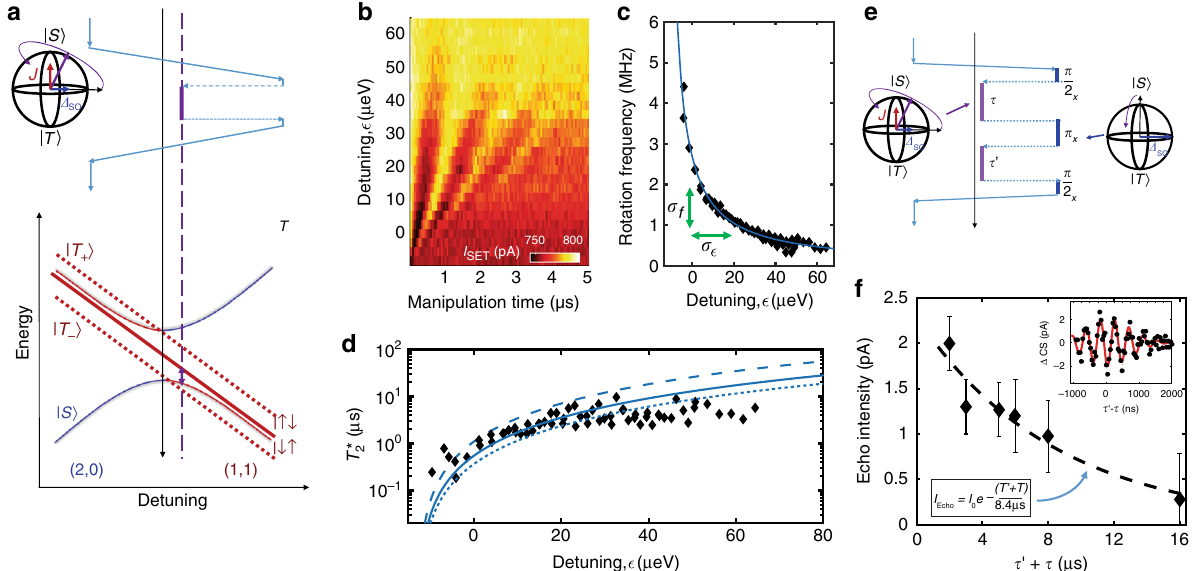
Fig. 4 Z- rotations and noise. a Energy Diagram and gate pulse schematic for controlling exchange rotations. We initialize the qubit into the S (2, 0) ground state and ramp adiabatically, such that it transfers to the ground in the (1, 1) charge sector. A fast pulse to and from a detuning, ϵ , where J is substantial drives coherent rotations around an axis depending on both J and Δ SO . Returning to the (2, 0) charge sector adiabatically projects the states onto the S (2, 0) and T 0 (1, 1) basis for measurement. b Measured charge sensor current as a function of the time spent rotating for various detuning points. Here, high current corresponds to a higher probability of measuring a singlet. c The extracted rotation frequency vs. detuning. The blue line is a fi t to the form ffiffiffiffiffiffiffiffiffiffiffiffiffiffiffiffiffiffiffiffiffiffiffi q as a function of detuning. We also plot the long integration time values from Fig. 3a. The blue lines are fi ts J ð ϵ Þ 2 þ Δ 2 , where J ( ϵ ) ∝ ϵ − 1 . d Extracted T ? 2 SO (cid:5) (cid:5) (cid:5) (cid:5) (cid:3) 1 , where the extracted charge noise, σ = 1 ffiffi (cid:4) d f μ eV (dotted). e Gate pulse schematic for a Hahn-echo p to the form T ? ϵ , is 1 (dashed), 2 (solid) and 3 2 πσ e d ϵ 2 sequence. We initialize the qubit into the S (2, 0) ground state and transfer the system to the (1, 1) charge sector with a rapid adiabatic pulse such that it remains in a singlet state. Combinations of Δ SO -rotations about the X -axis and J -rotations about a second axis provide access to entire Bloch sphere. This echo sequence counteracts low frequency noise, prolonging qubit coherence. f Hahn-echo amplitude as a function of total time, τ ′ + τ , exposed to charge = 8.4 μ s. (inset) noise at detuning ϵ . The error bars represent 95% con fi dence interval. A fi t to an exponential decay gives qubit coherence time of T echo 2 e Measured echo signal for τ = 1 μ s with B = 0.141 T along the [110] direction. The change in charge sensor current ( Δ CS) due to the echo signal has an = 1 μ oscillation frequency corresponding to Δ SO and a Gaussian envelope around τ = τ ′ with a decay due to the inhomogeneous dephasing time of T (cid:5) 2 e